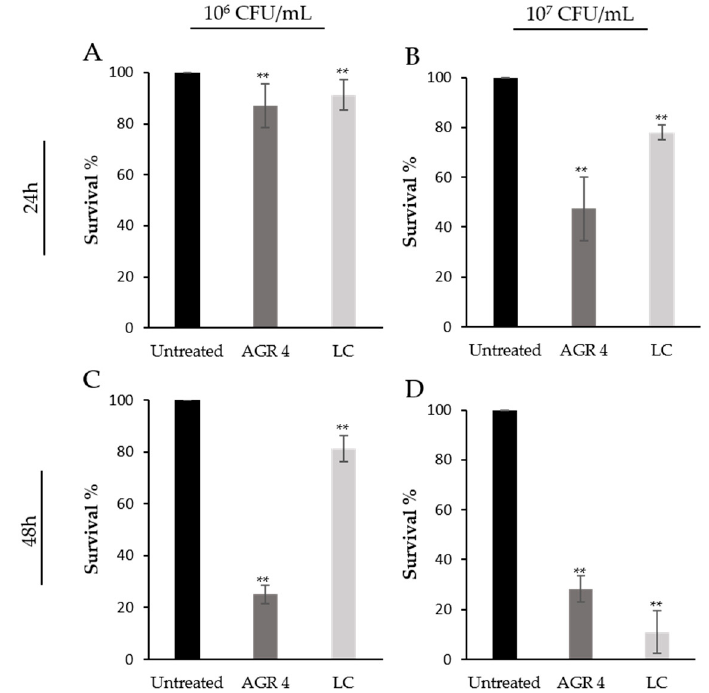
Figure 5. Time- and dose-dependent antiproliferative e ff ects of viable Lactobacillus AGR 4 on A375 cells, measured by SRB assay. The human melanoma cell line, A375, was incubated with 10 6 CFU / mL ( A , C ) or 10 7 CFU / mL ( B , D ) of Lactobacillus AGR 4 for 24 ( A , B ) and 48 h ( C , D ). Lactobacillus casei (LC) ATCC 393 served as a reference strain. Data is presented as the mean ± standard deviation of three independent experiments. ** p < 0.01 compared to untreated cells.